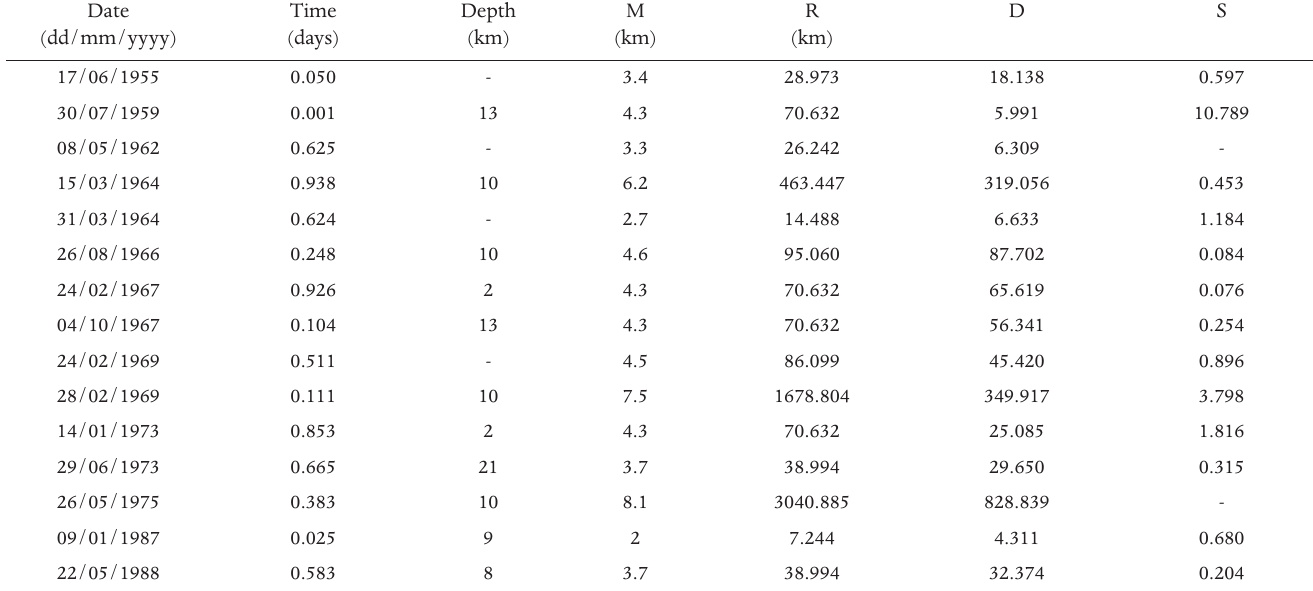
Table 1. The 15 seismic events of interest, where S > 0 (see Equation 2), in the period from 1955 to 1991 (data provided by the Portuguese